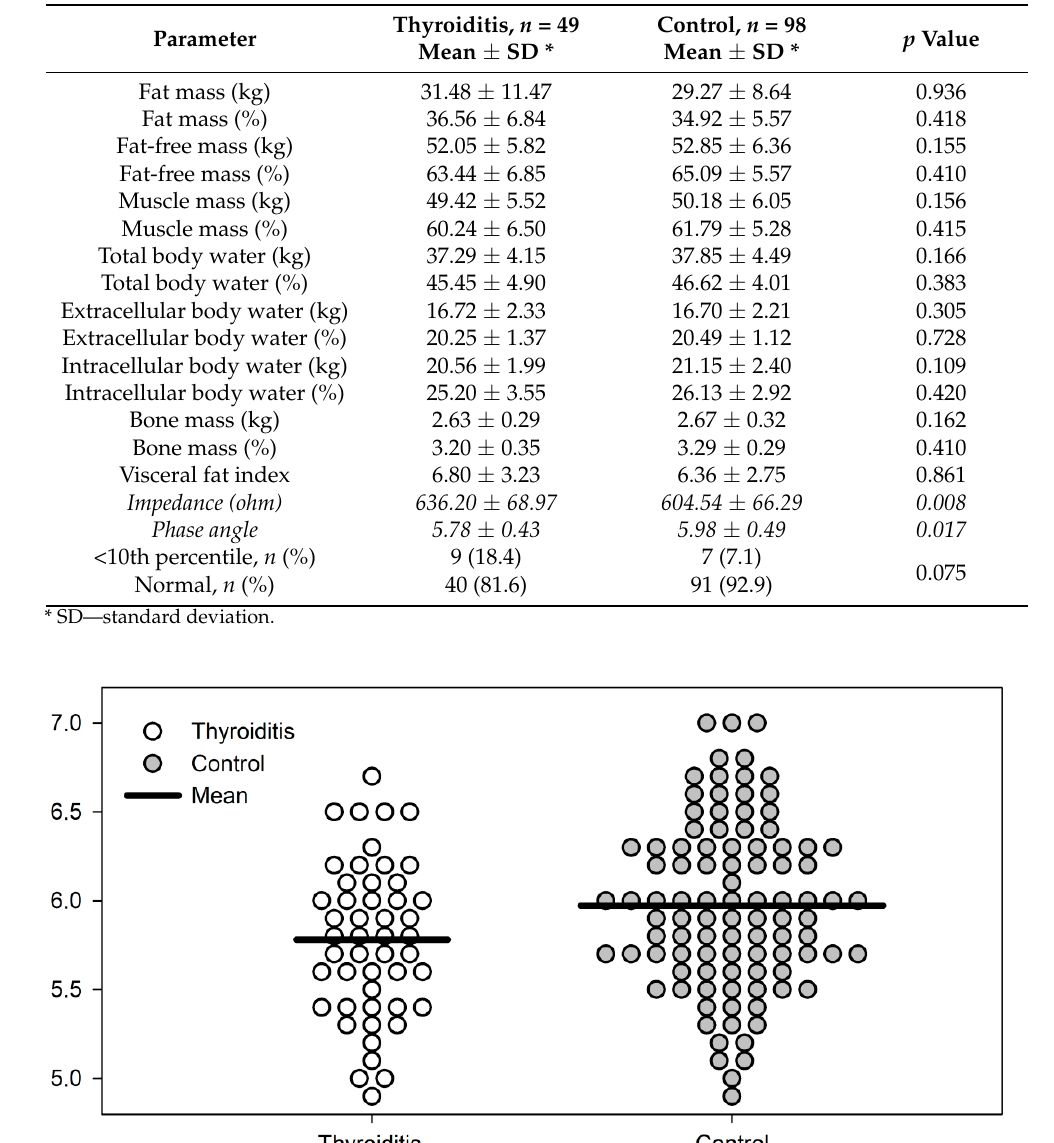
Table 2. Body composition parameters in the study and control groups. Significant differences are emphasized in italics.